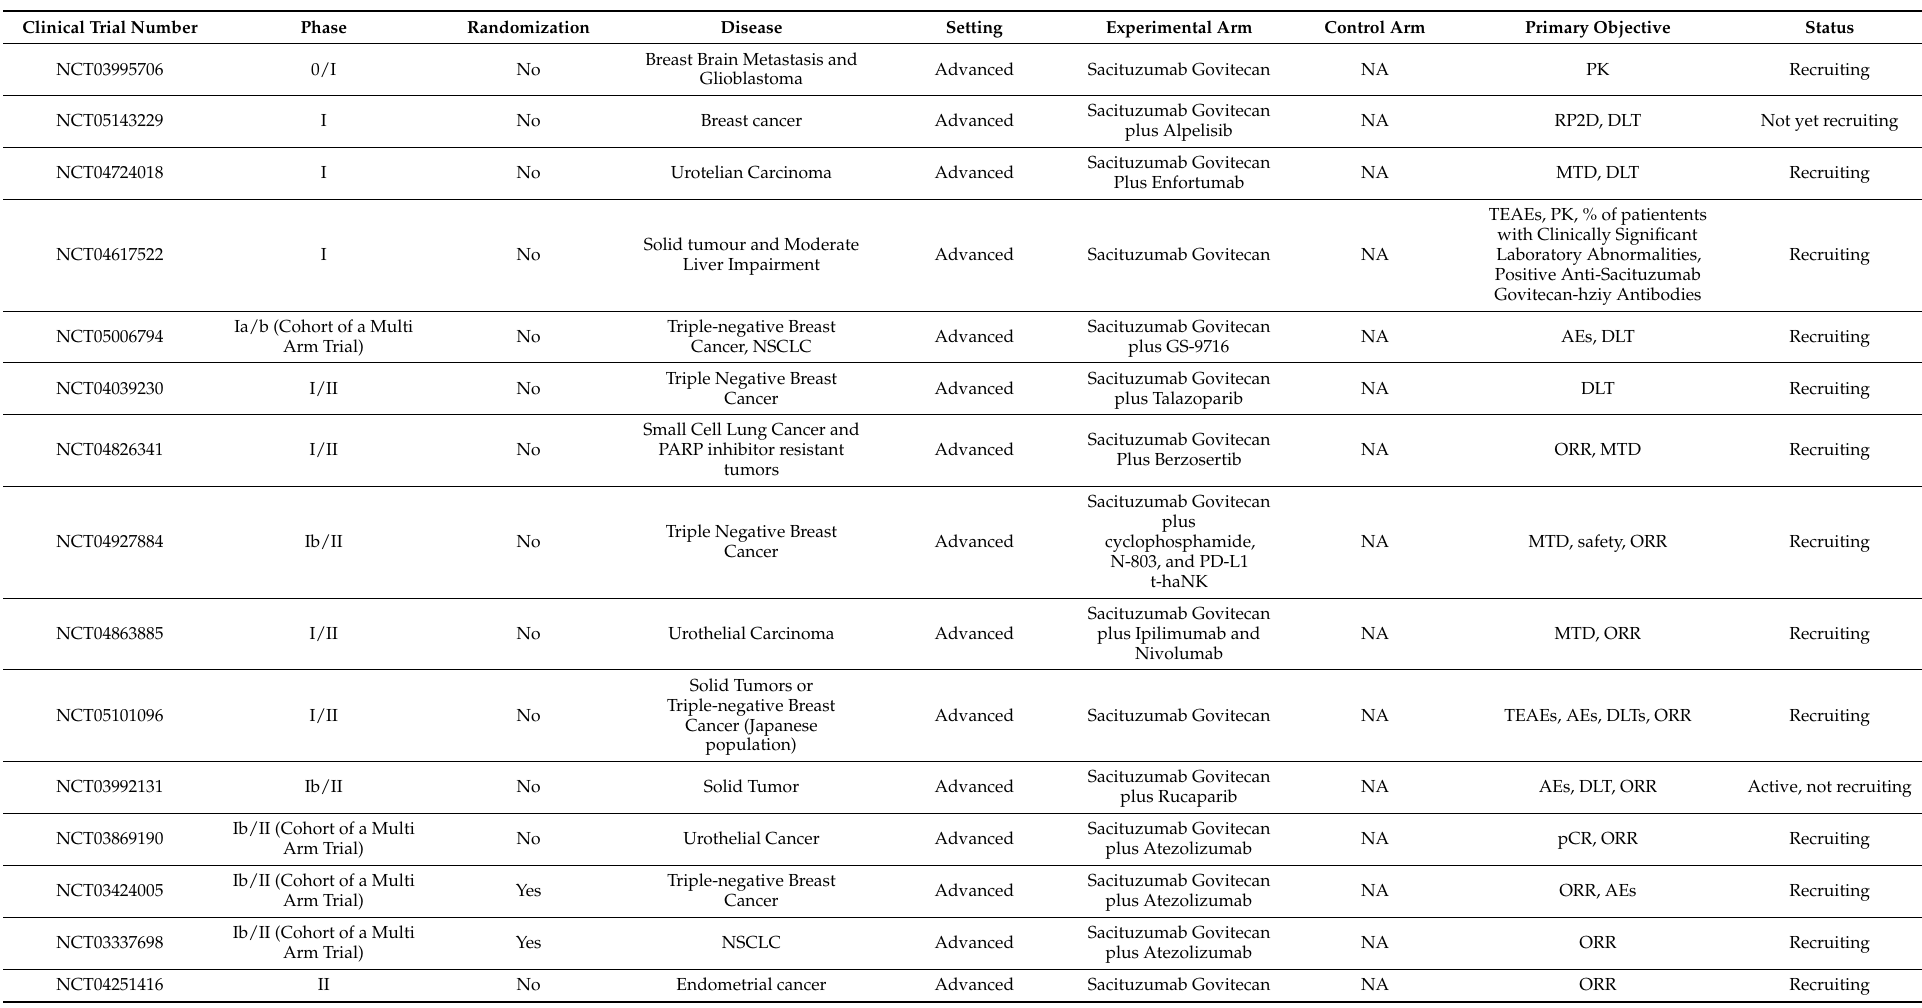
Table 2. Ongoing clinical trials with Sacituzumab